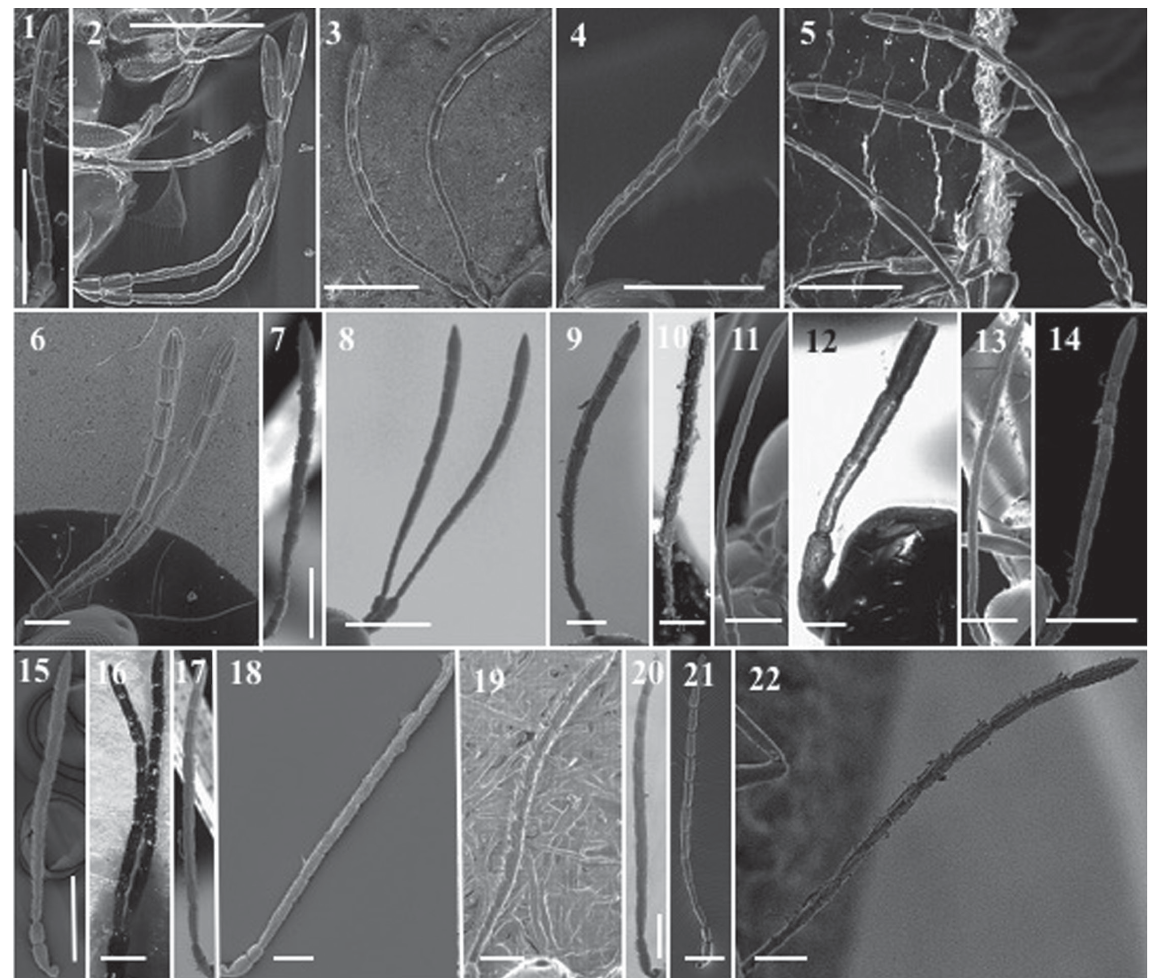
Fig. 6. Types of antenna of Dilyta Förster, 1869 and Phaenoglyphis Förster, 1869. 1 . D. aleevae Pujade- Villar & Paretas-Martínez, 2011. 2 . D. japonica Paretas-Martínez & Ferrer-Suay, 2011. 3 . D . longinqua Paretas-Martínez & Pujade-Villar, 2011. 4 . D. rathmanae . 5 . D. sinica Ferrer-Suay &